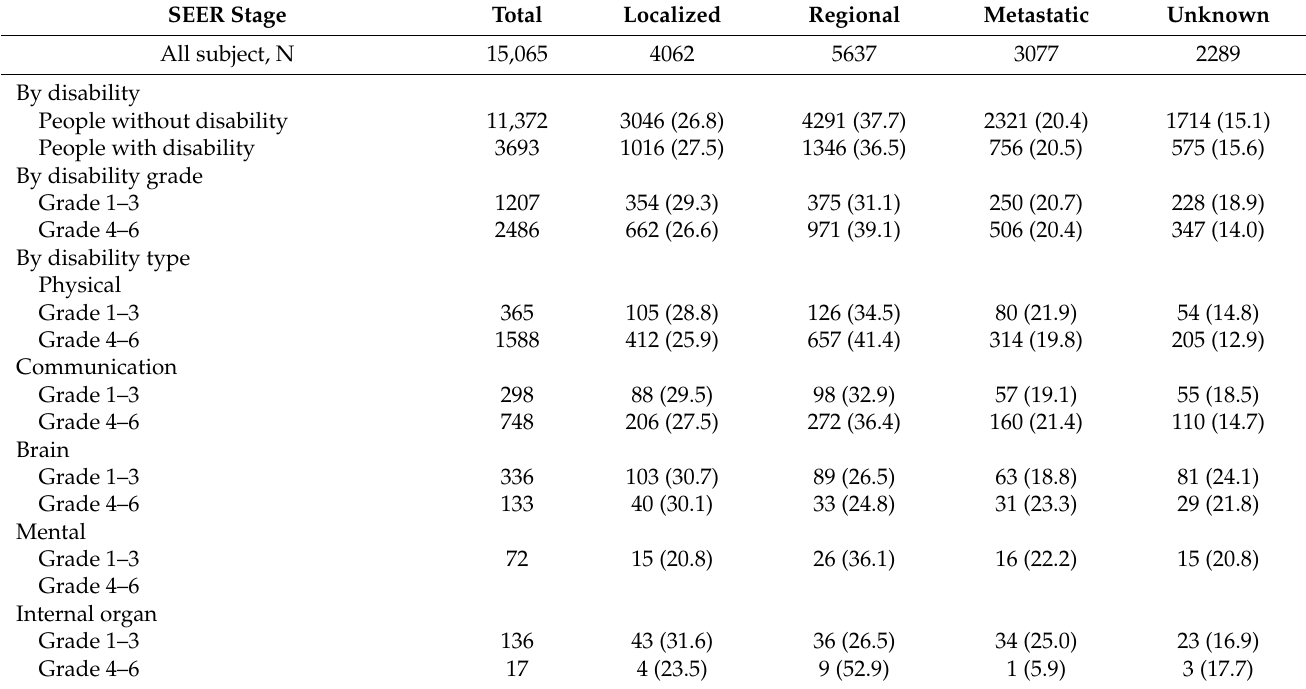
Table 2. Disability characteristics in patients with localized, regional, and metastatic bile duct